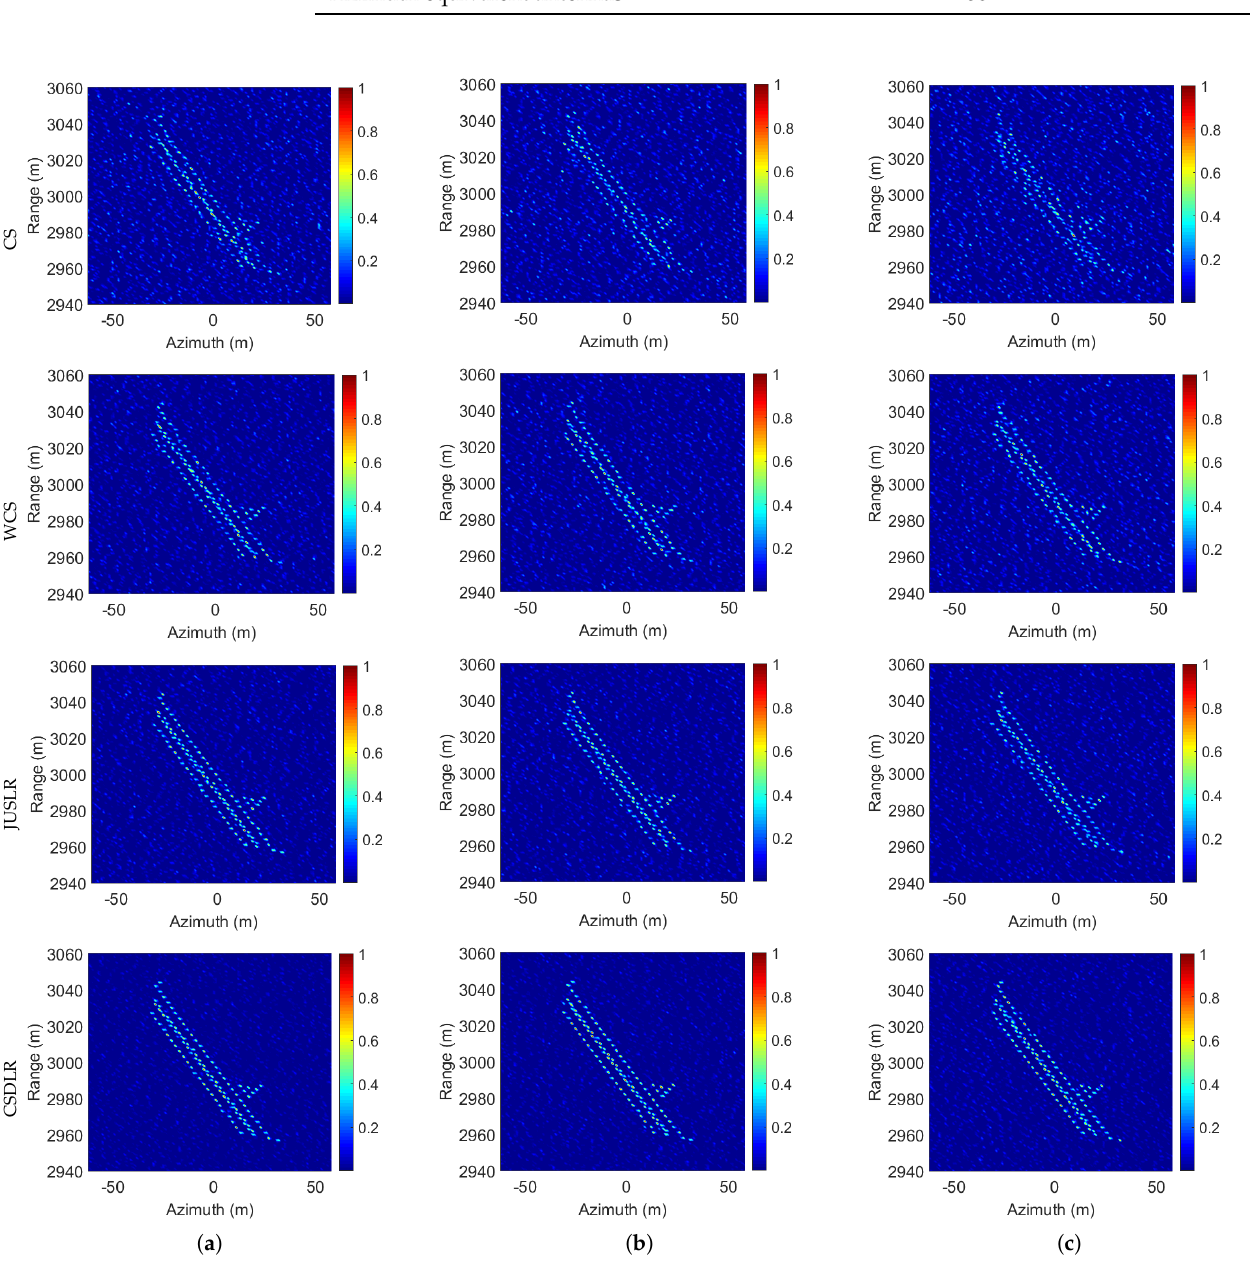
Figure 8. Comparison of imaging results of different methods in ship surface target